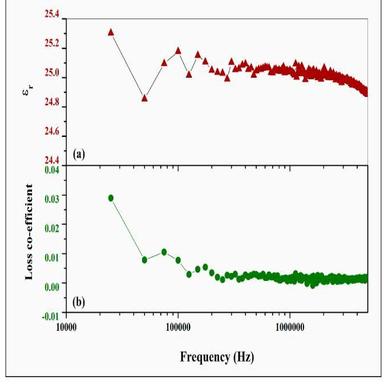
(a) Dielectric permittivity vs frequency (b) Loss co-efficient vs frequency plots of GuHM.